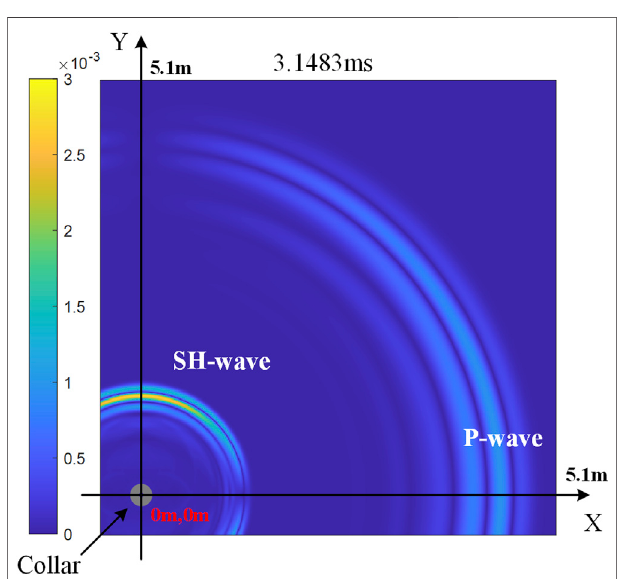
FIGURE 3 | The snapshot of the total vibration velocity fi eld in xoy -plane at 3.1483 ms